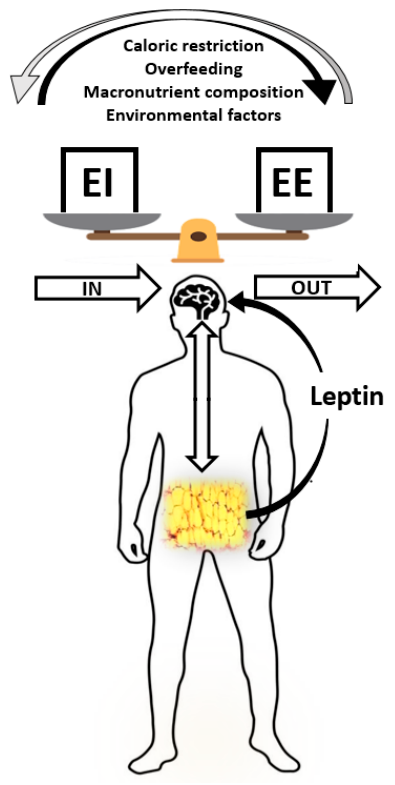
Figure 1. Energy balance and the adipose organ. Disequilibrium in energy balance regulation can be caused by several factors such as caloric restriction, dietary overfeeding, different macronutrient com- positions and several environmental perturbing factors, including those causing chronodisruption. The adipose tissue plays an active role in the regulation of energy balance, not only as a site for lipid storage but also being involved in heat generation (in brown adipose tissue) and adipokine secretion. The adipose organ serves as a dynamic energy depot that constantly conveys signals to the central nervous system to communicate the amount of energy stores and to elicit compensatory